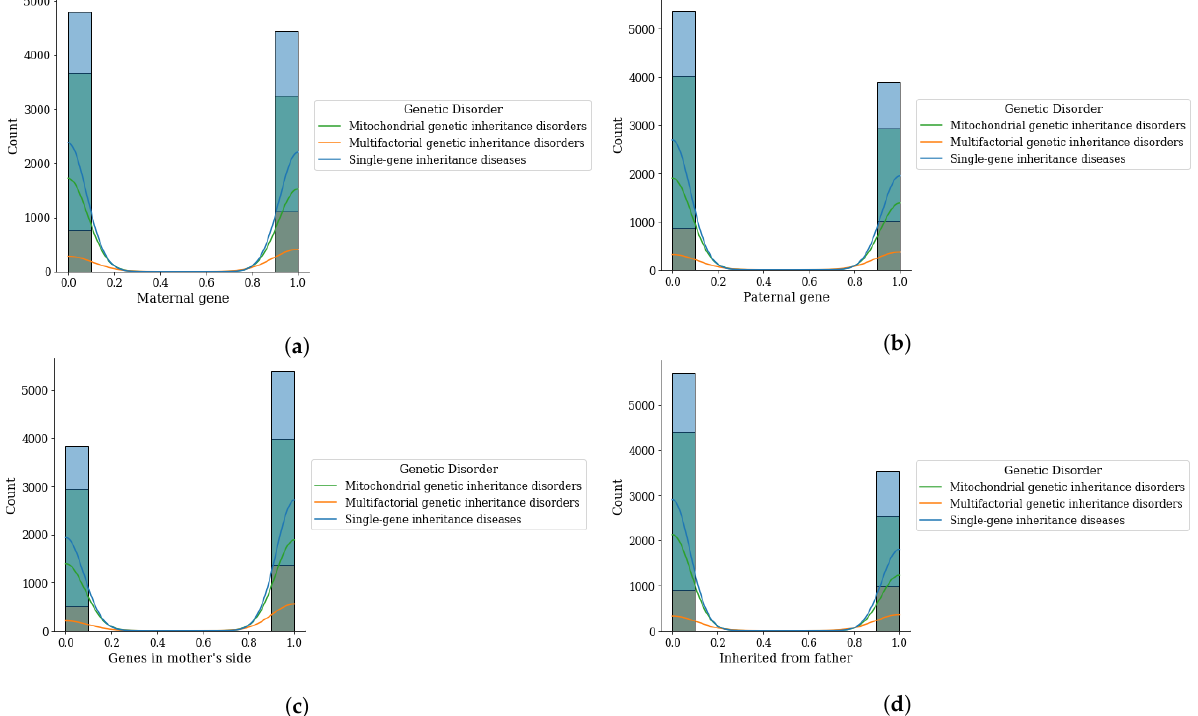
Figure 4. Genomes data distribution by genetic disorder category, ( a ) maternal gene, ( b ) paternal gene, ( c ) genes from mother side, and ( d ) inherited from